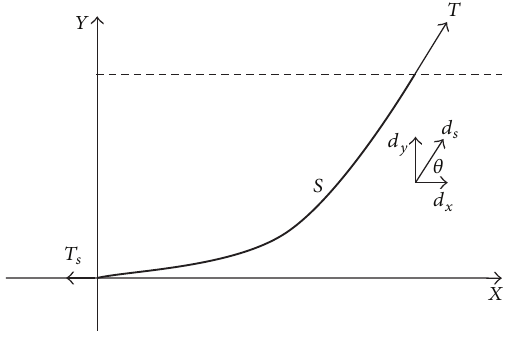
Figure 1: SCR installation procedure.